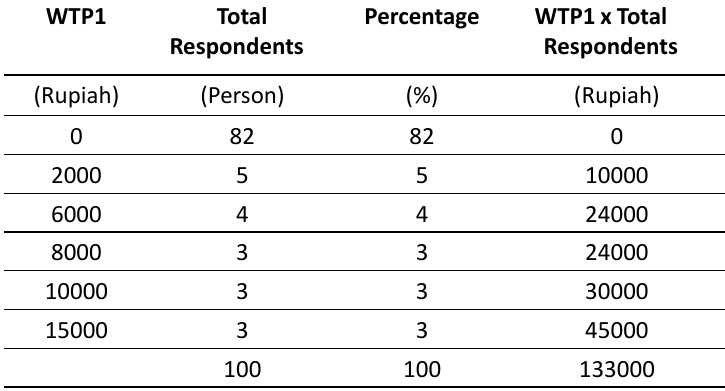
Table 5: Distribution of WTP Value on Scenario 1